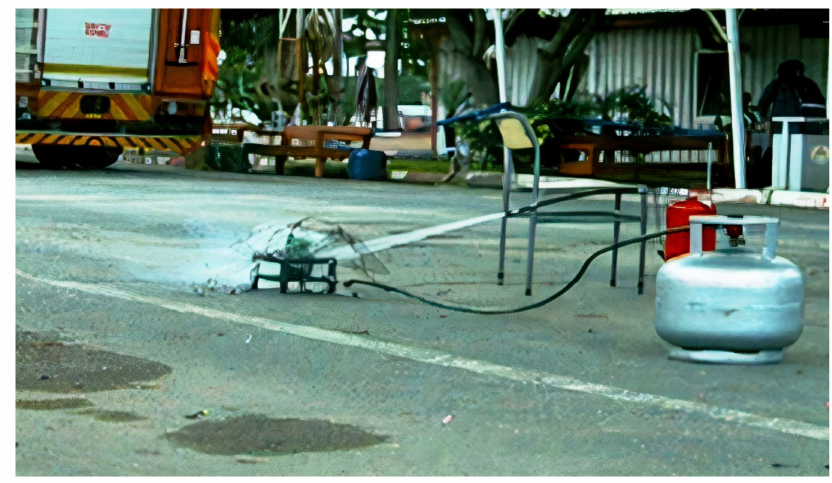
Figure 25. Exp. B.2 experiment.